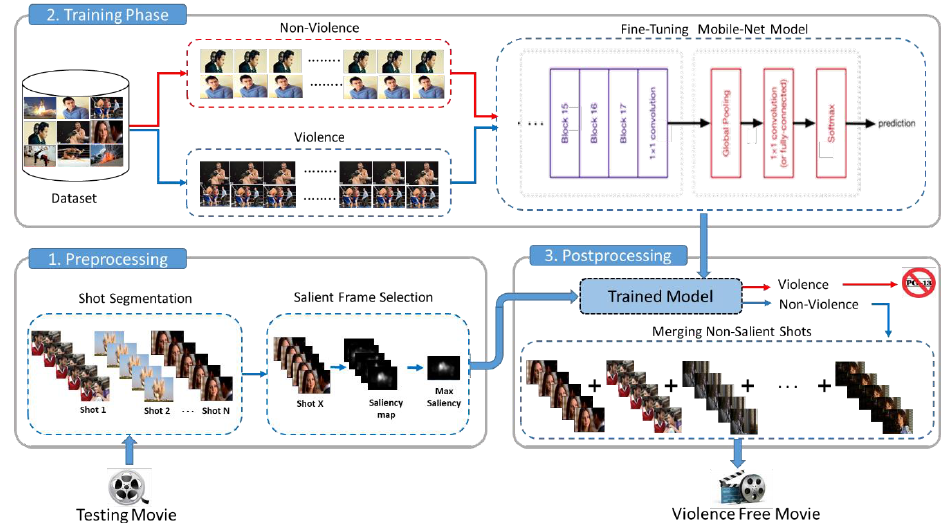
Figure 1. Proposed framework for violent scene detection in movies.